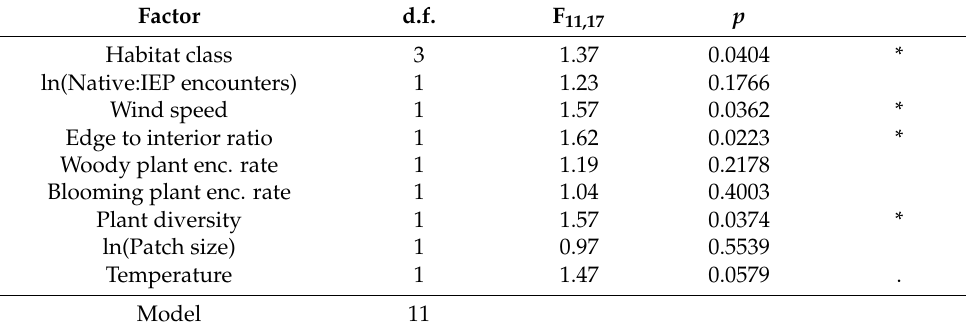
Woody plant enc. rate